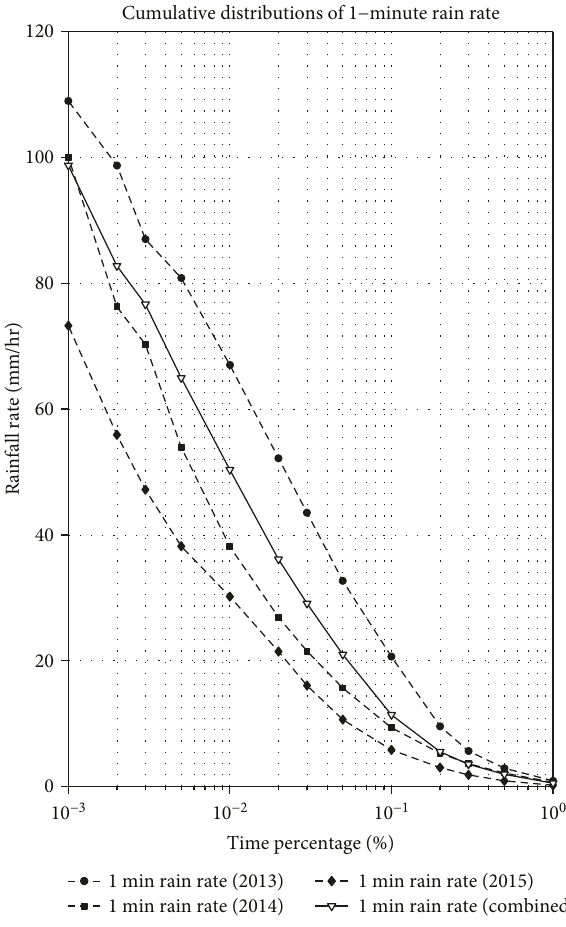
Figure 3: Distribution of rain attenuation for various rain exceedance values at Icheon